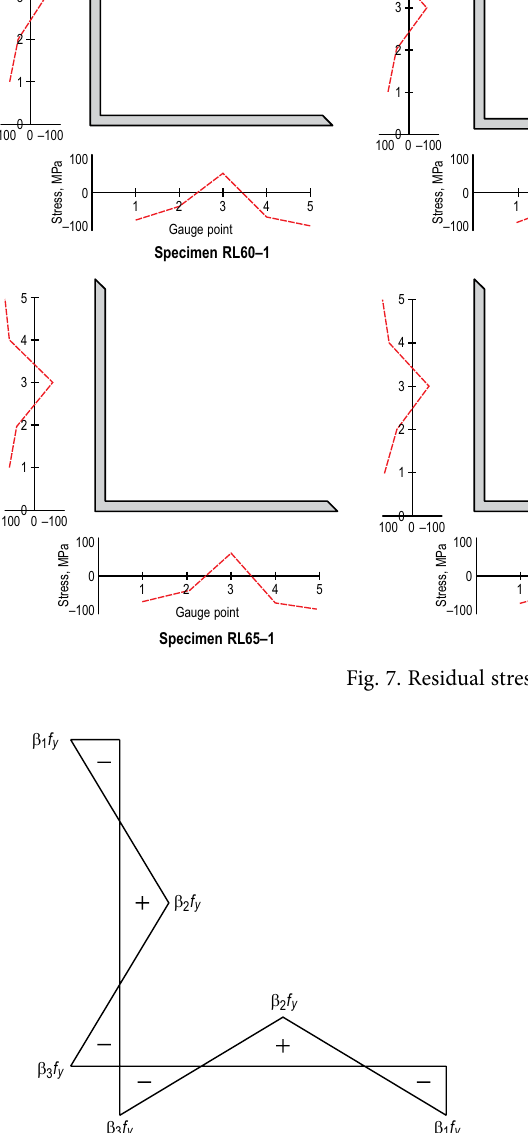
Fig. 9. Relationship between the residual stress and the width-thickness ratio of the angle